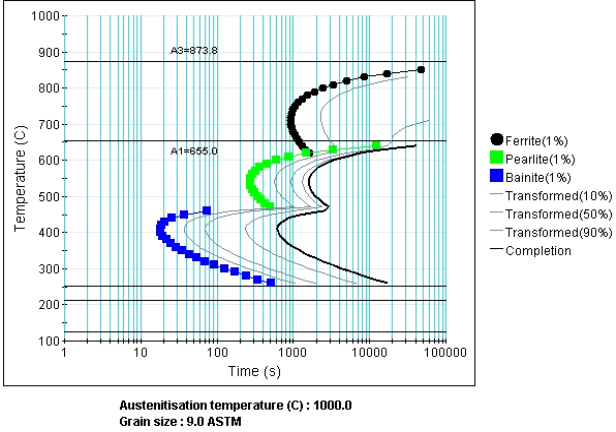
Figure 5. Predicted time-temperature-transformation (TTT) diagram of 3 Mn steel determined using the JMatPro package.